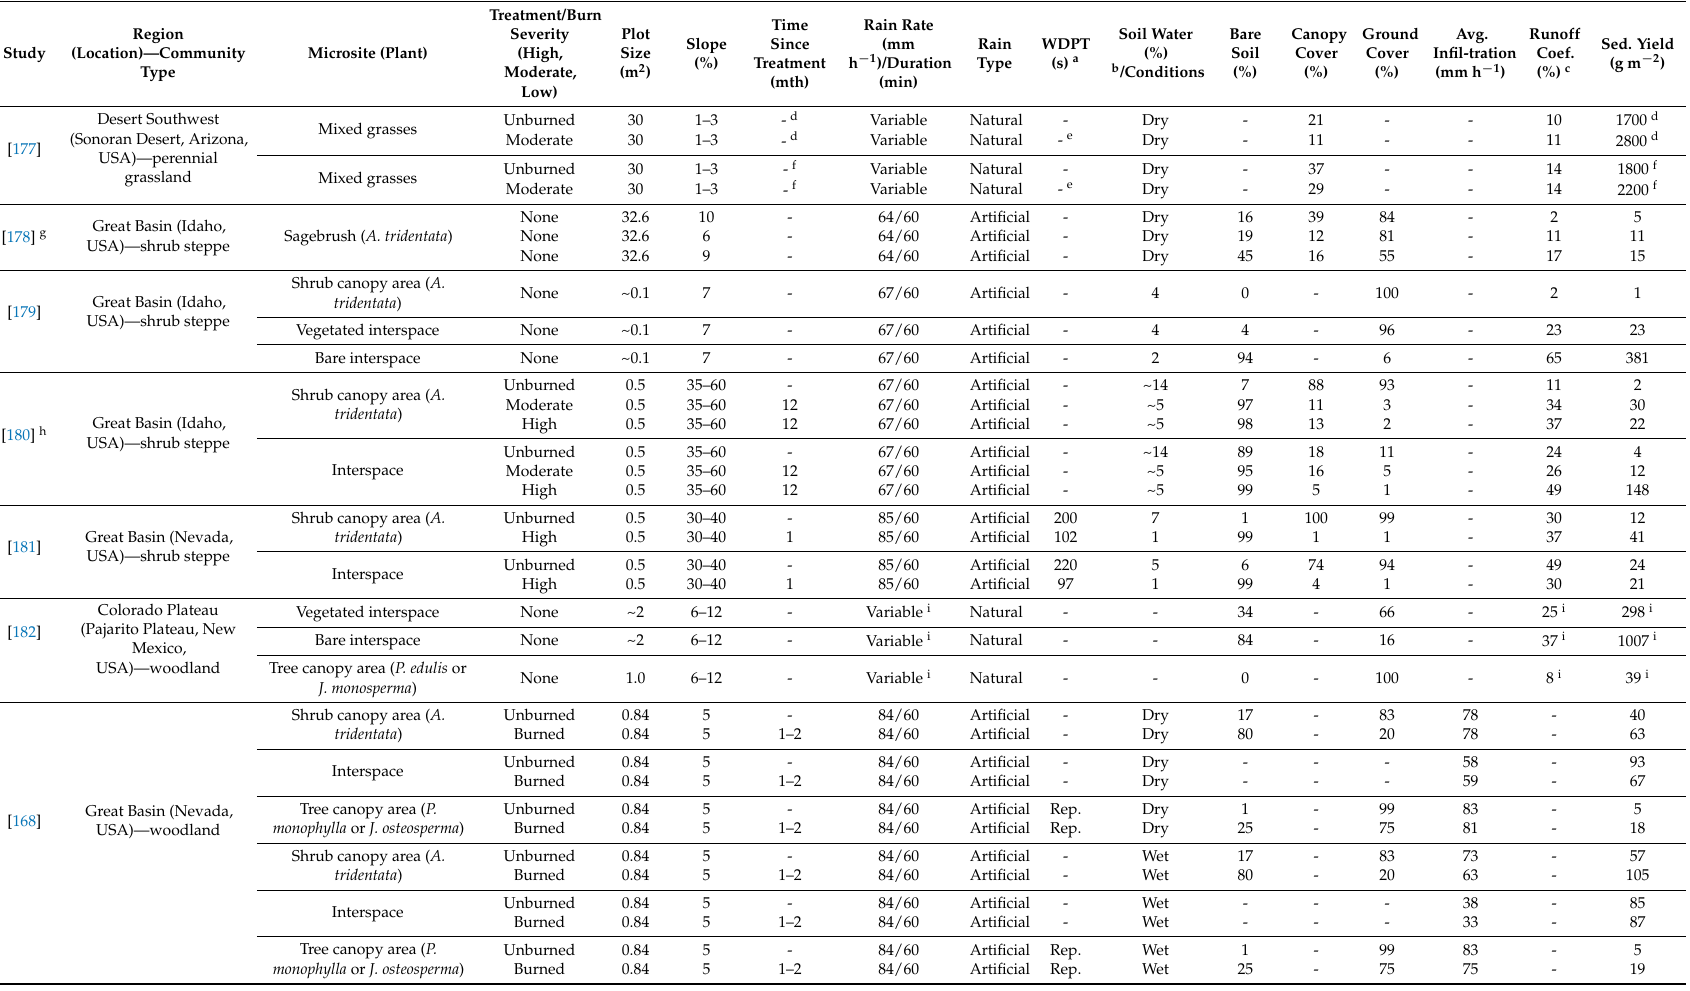
Table 2. Site characteristics, infiltration, runoff coefficients, and sediment yields for rainfall simulation and natural rainfall studies in the western US. Modified from Pierson and Williams